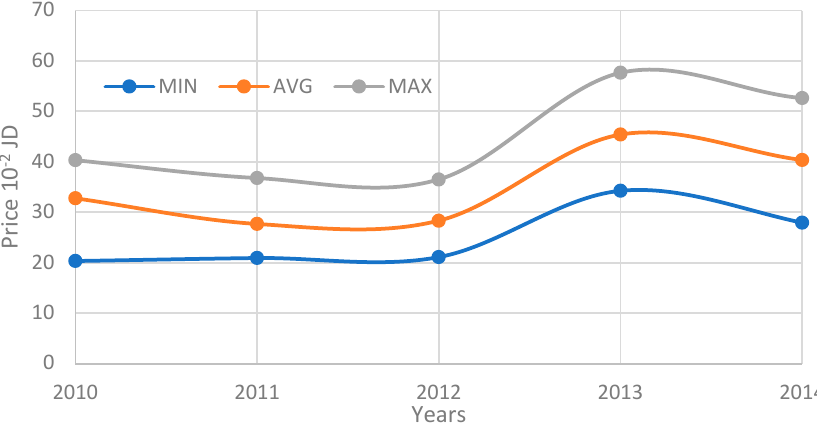
Figure 3. Prices jump as a result of Syrian immigration to Jordan.